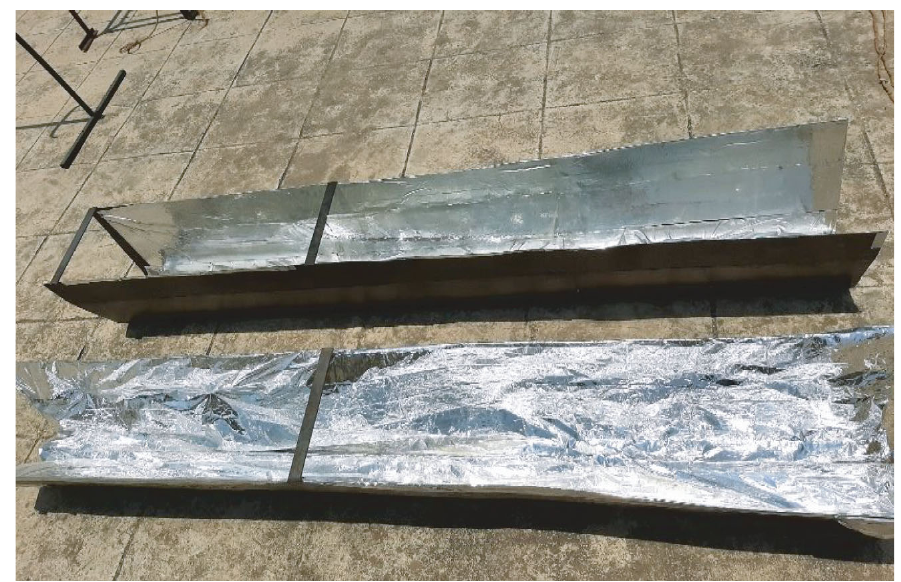
Figure 2: CPC with aluminum foil and chrome mirror silver vinyl